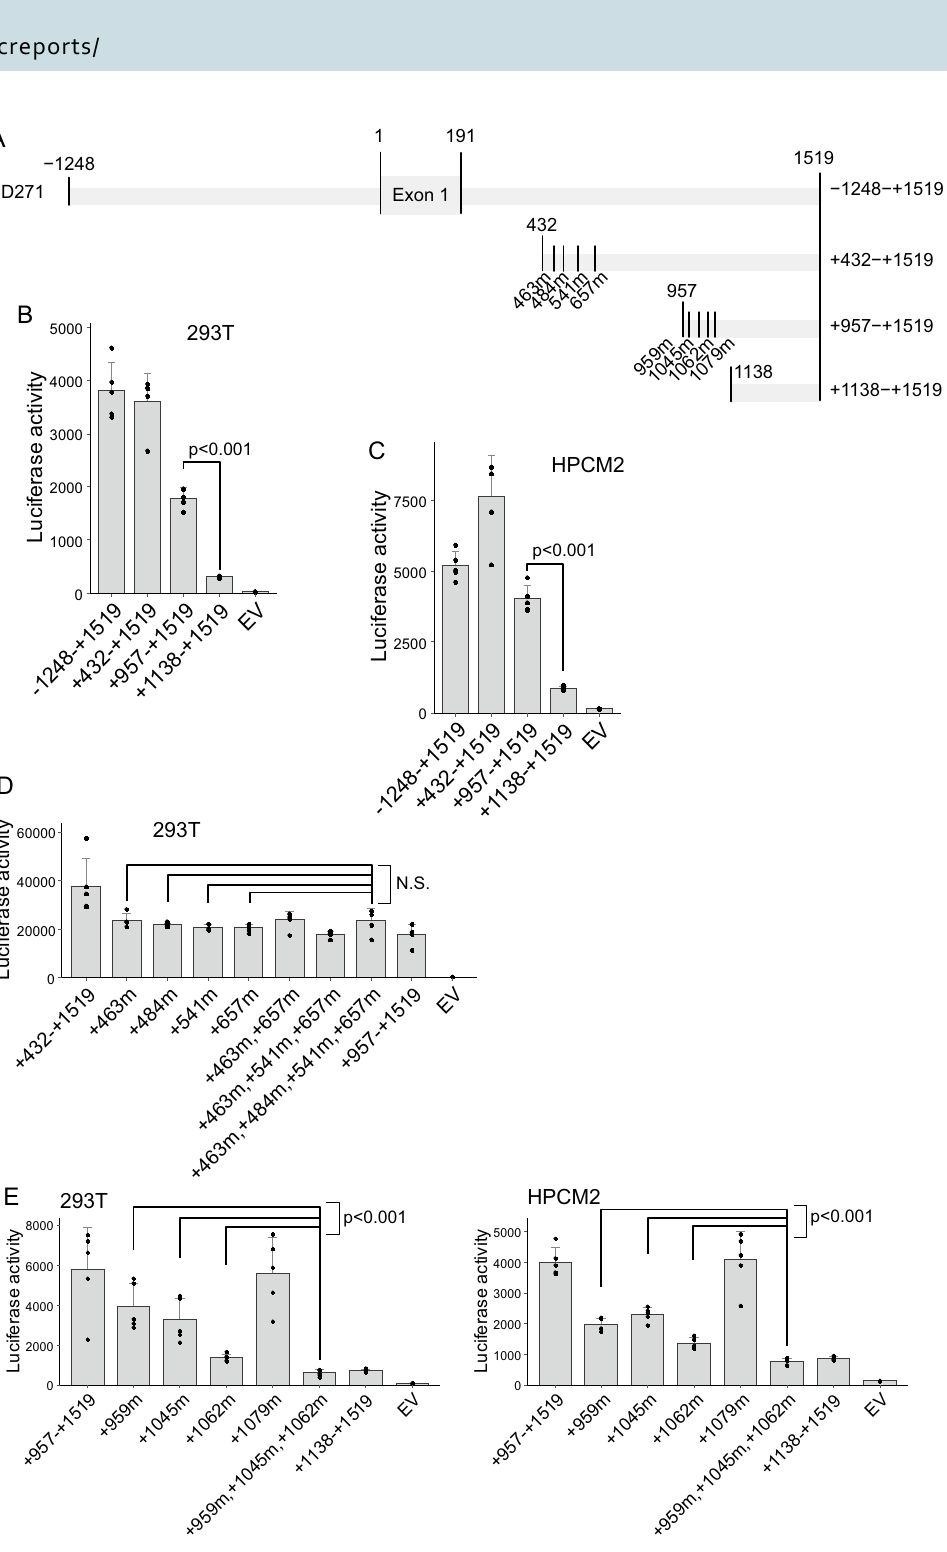
Figure 4. Identification of the RELA-binding site(s) for CD271 expression. ( A ) Schematic of the CD271 promoter region and its deletion mutants. ( B )–( E ) Luciferase assay. 293 T or HPCM2 cells were transfected with a vector containing the CD271 promoter region fused along with a luciferase reporter and a RELA -expression vector. Luciferase activity was measured two-days